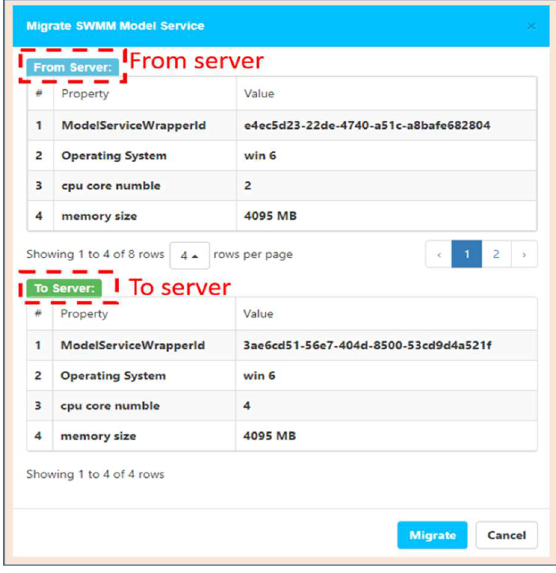
Figure 17. Model service migration.